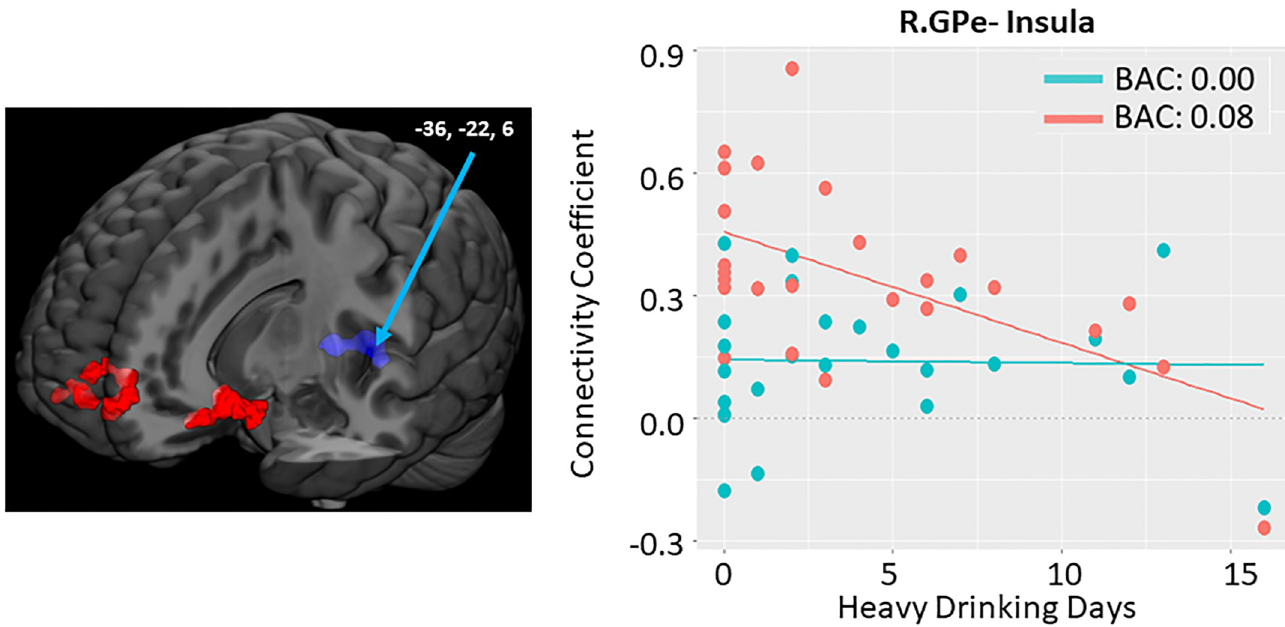
Fig 4. Association between heavy drinking days and alcohol induced changes in GPe connectivity. (As measured by the Alcohol Timeline Followback). Scatter plots correspond to individual connectivity at baseline in teal (estimated BAC: 0.0) and after infusion in salmon (BAC: 0.08); linear fit lines are also displayed for each timepoint. Connectivity coefficient is the r (correlation value) between the signal in the right GPe seed and the coordinate indicated. Brain images represent whole effects of drinks in past 30 days on alcohol induced change in functional connectivity (post-infusion connectivity > pre-infusion connectivity). Warm colors indicate intoxication related increases in connectivity; cool colors indicated intoxication related decreases in connectivity. Images shown at p < 0.005. Heavy Drinking Days as measured by the Alcohol Timeline Followback in the last 90 days. Abbreviations: R.GPe- Right Globus Pallidus Externus.